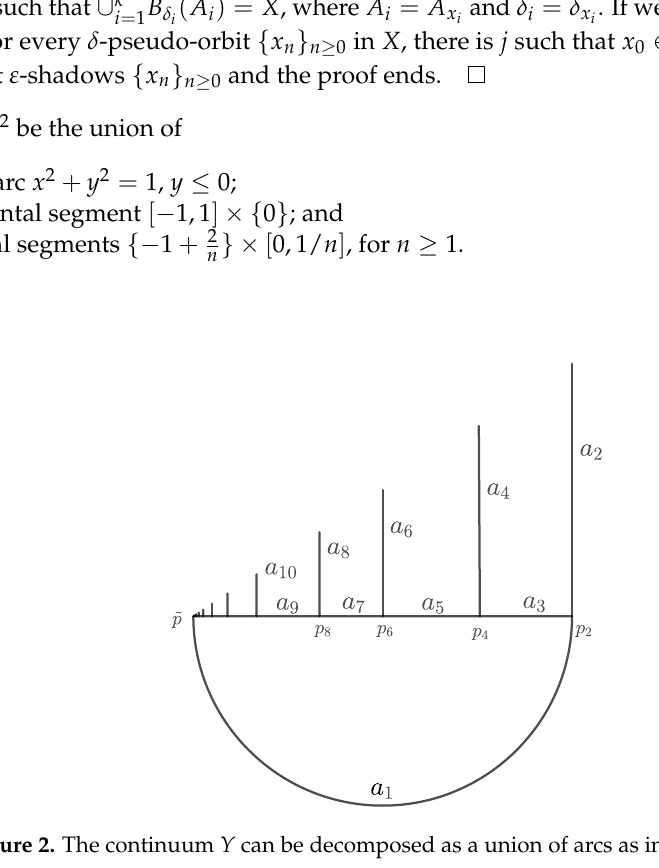
Figure 2. The continuum Y can be decomposed as a union of arcs as in Proposition